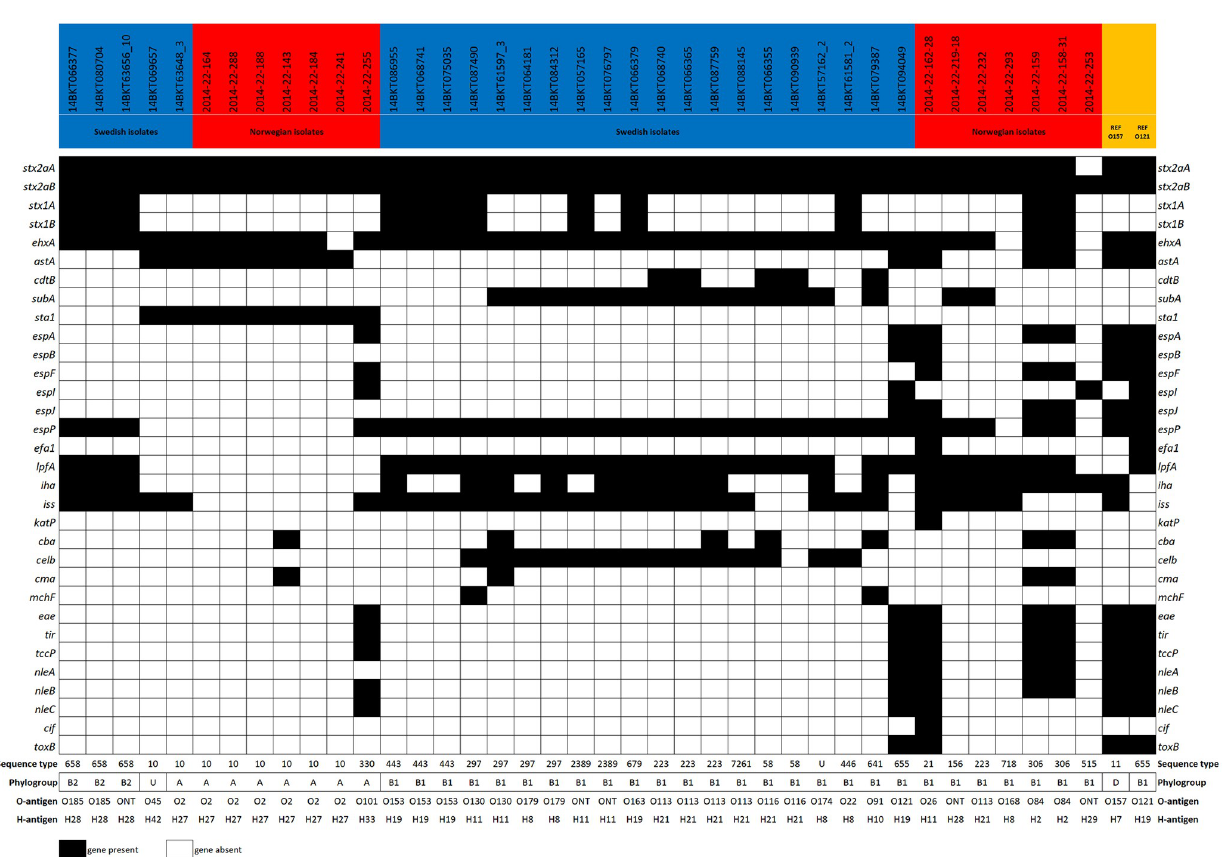
Fig 2. Virulence gene profiles, sequence types, phylogroups and serotypes of 39 stx 2a -positive E . coli isolates from cattle in Sweden and Norway. Two outbreak strains of EHEC (O157:H7 TW14359 and O121:H19 16–9255) are included as references. U; undetermined phylogroup or sequence type. ONT; antigen non-typable. O2 not distinguishable from O50. O101 not distinguishable from O162. O153 not distinguishable from